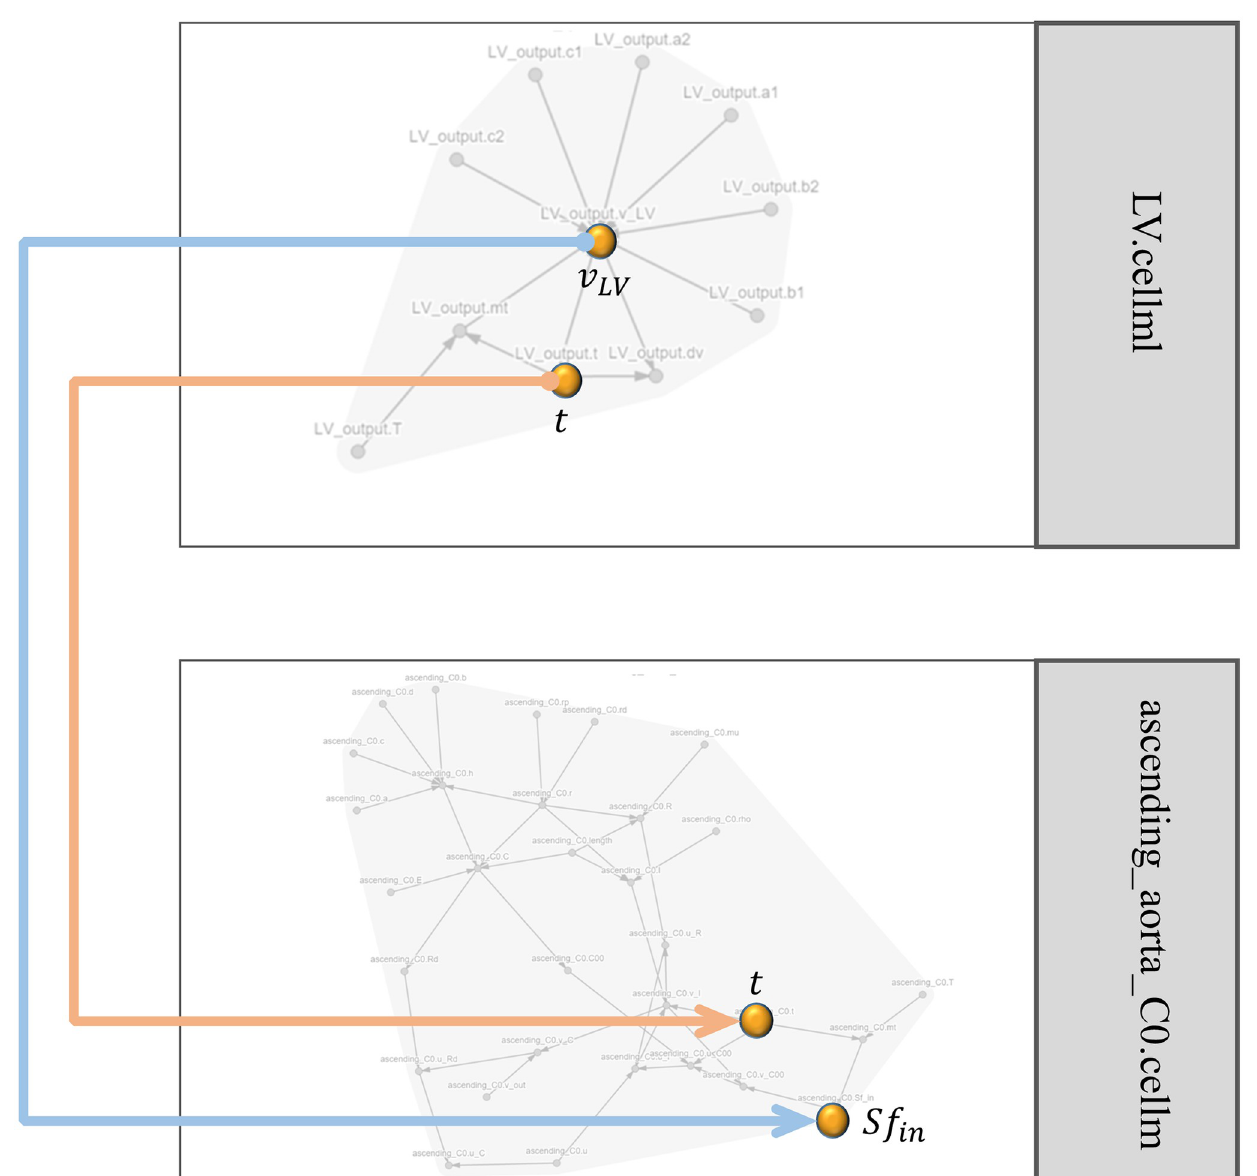
Fig 10. The SemGen merger tool visualisation for two modules. The model of left ventricle output flow (LV.cellml) is merged with the model of the ascending aorta (ascending_aorta_C0.cellml). Time (t) and the amount of the flow ( v ) in the LV.cellml module are mapped to the time (t) and the source LV of flow ( Sf in ) variables in the ascending_aorta_C0.cellml module. The grey lines show the internal dependencies between the variables in each module and the orange and blue lines show the links between the